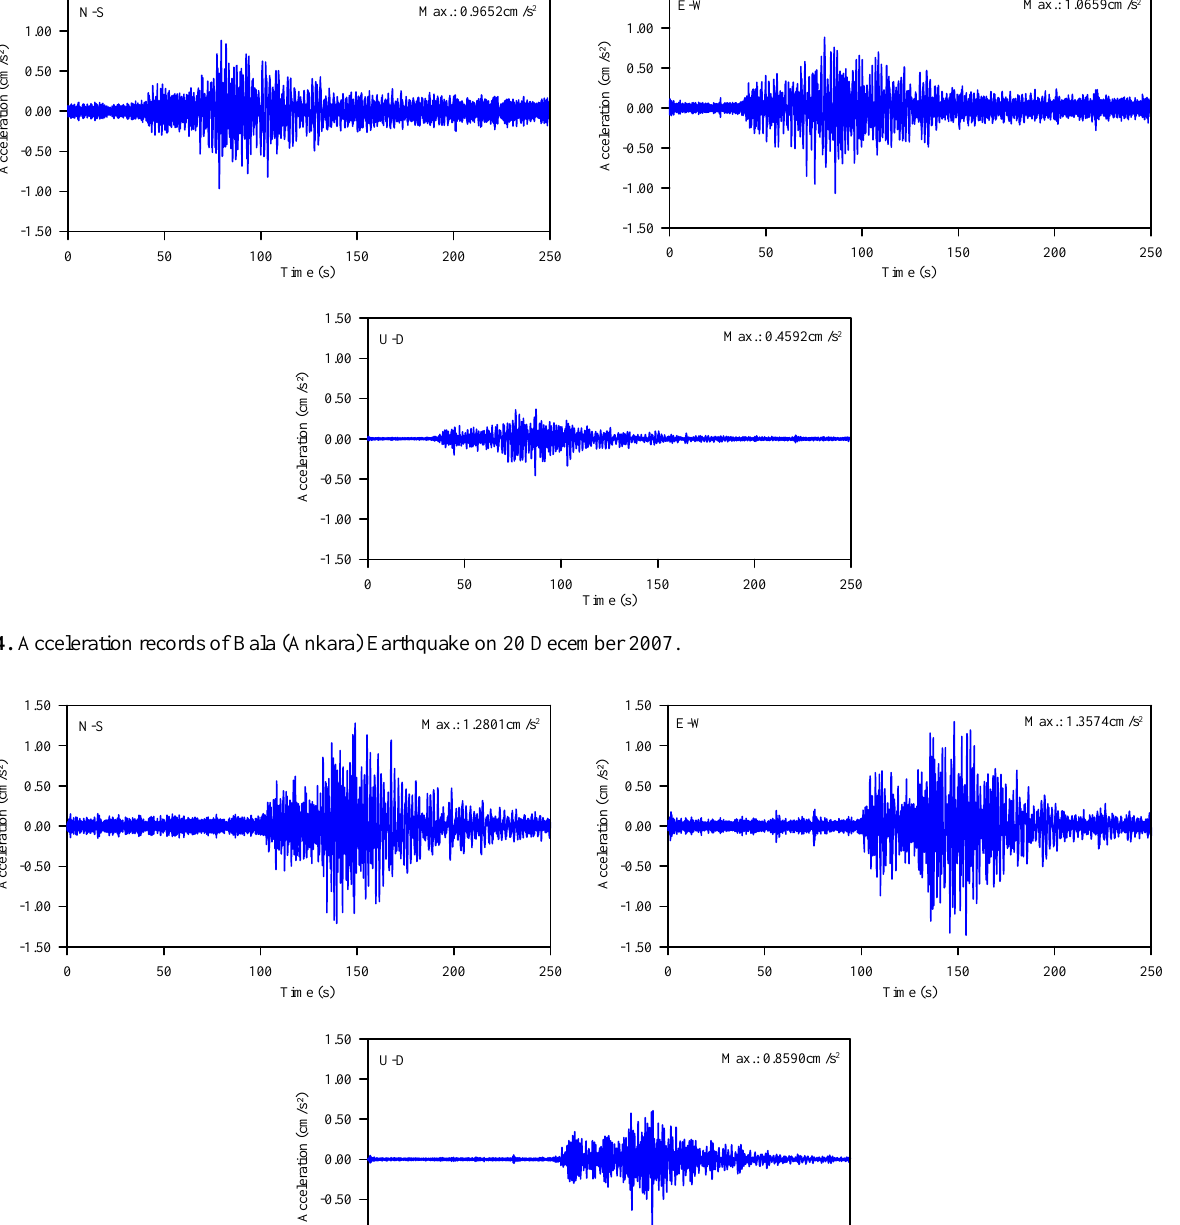
Fig. 4 Acceleration records of Bala (Ankara) Earthquake on December 20, 2007.